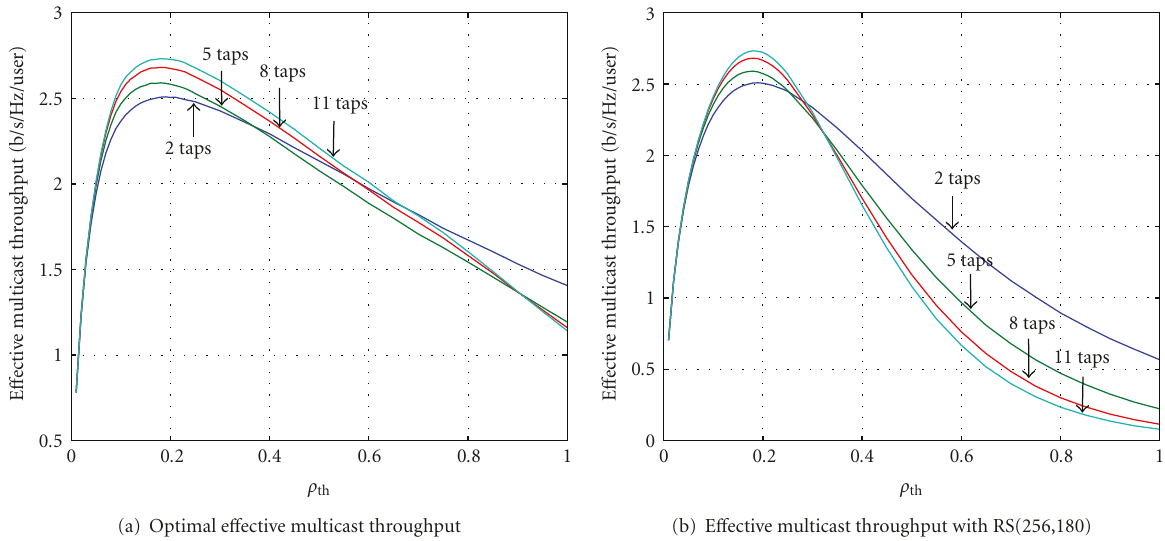
Figure 11: E ff ective multicast throughput versus ρ th for ECOMP scheme in di ff erent numbers of resolvable paths with average SNR of 20 dB.